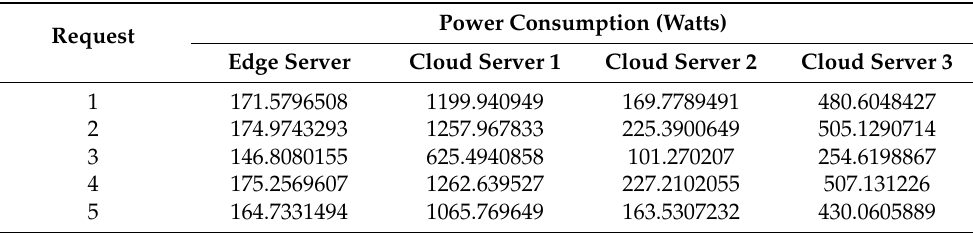
Table 2. Power consumption values of requests on the edge and cloud servers used in the